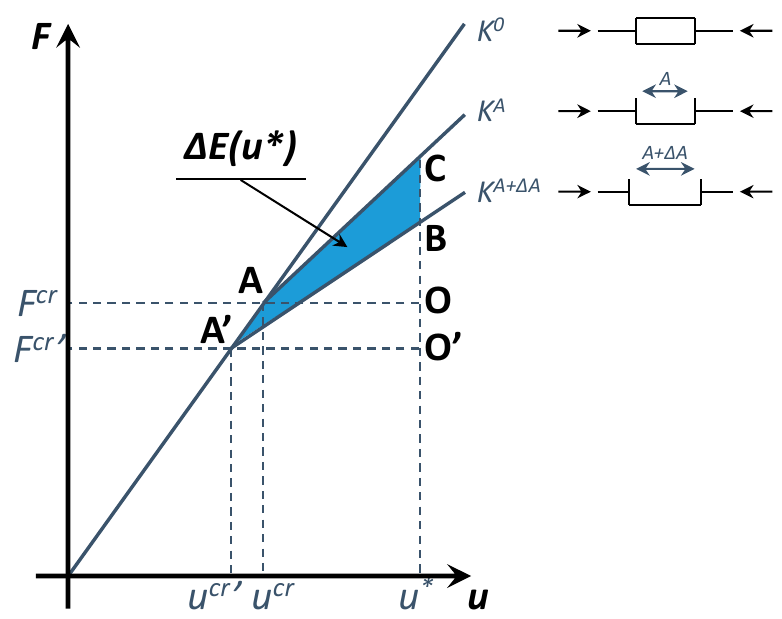
Figure 2. Sti ff ened composite panel sti ff ness: K 0 : Before delamination buckling; K A : After the local Figure 2. Stiffened composite panel stiffness: K 0 : Before delamination buckling; K A : After the local delamination buckling; and K A + ∆ A : After the propagated delamination delamination buckling; and K A+ Δ A : After the propagated delamination buckling.